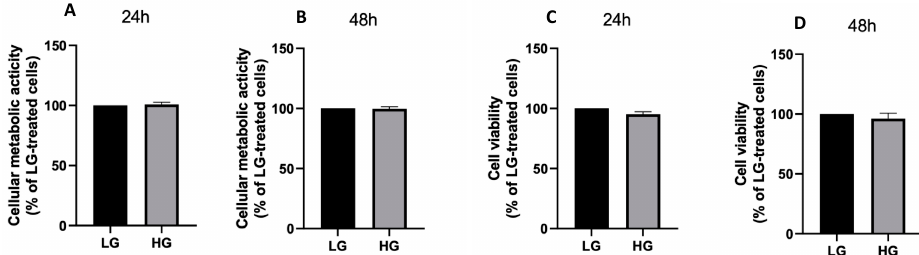
Figure 2. Cellular metabolic activity and viability in response to high glucose concentration. ARPE-19 cell metabolic activity ( A , B ) and cell viability ( C , D ) assessed after 24 ( A , C ) and 48 h ( B , D ) incubation with low glucose (LG, 5 mM glucose) or high glucose concentration (HG, 13 mM glucose). Data are expressed as mean ± SEM of at least three independent experiments.